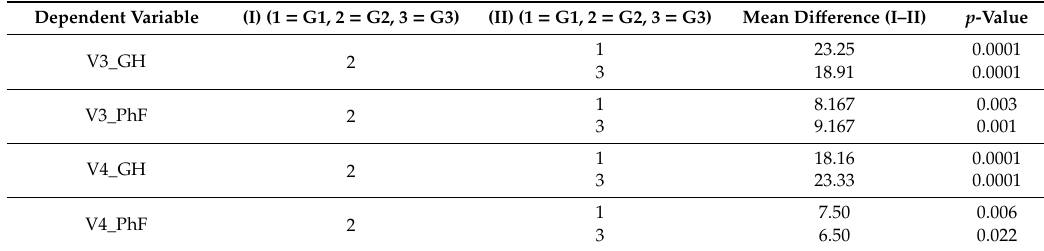
Table 5. Comparison of general health, physical functioning and physical role functioning at V3 and